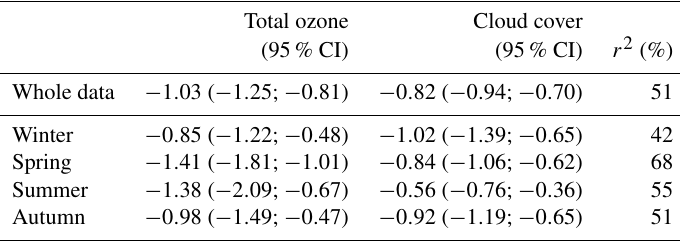
Table 6. Estimated effect on H er with 95% CI from the combined effect of both TO and CC trends for the period